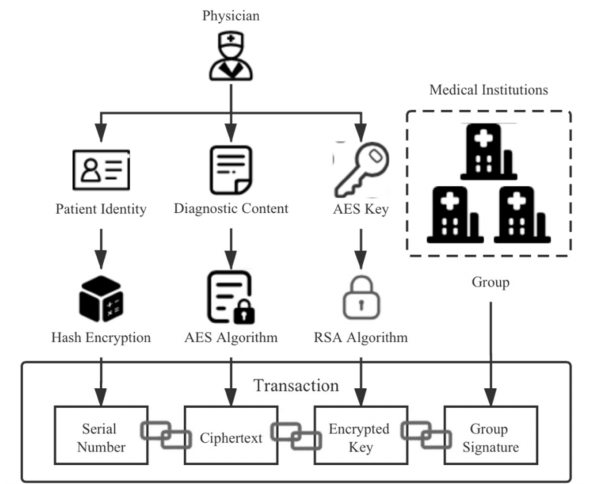
Figure 6. Transaction